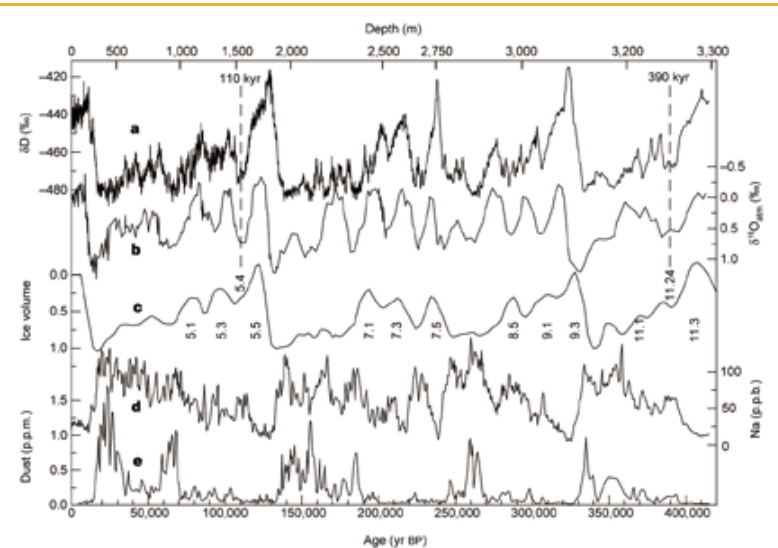
Figure 5. 420,000-year profiles of (1) deuterium, (2) δ 18 O atm , (3) seawater δ 18 O (ice volume proxy), (4) sodium, and (5) dust (Petit et al., 1999).